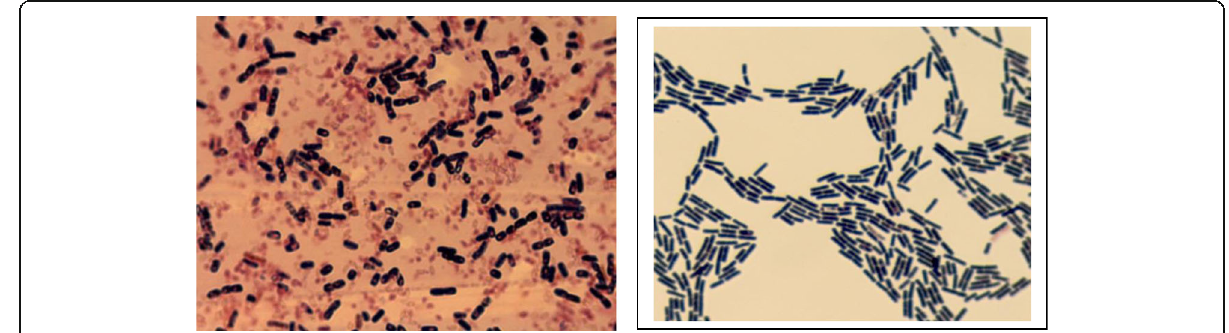
Fig. 1 Light microscope photomicroghraph of Gram stained Bacillus thuringensis isolates, Damietta isolate (left) and El-Sharkyia isolate